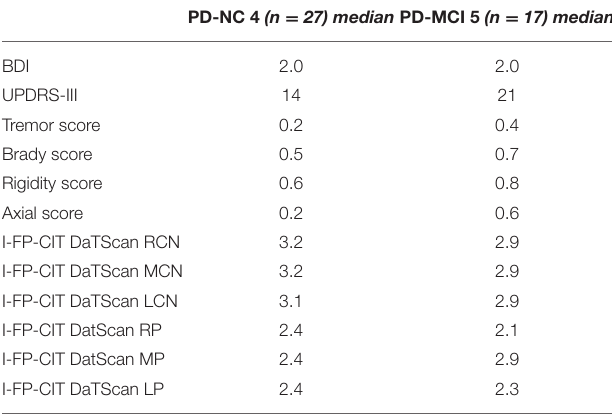
TABLE 2 | Descriptive statistics (median values) of the PD subgroups on clinical